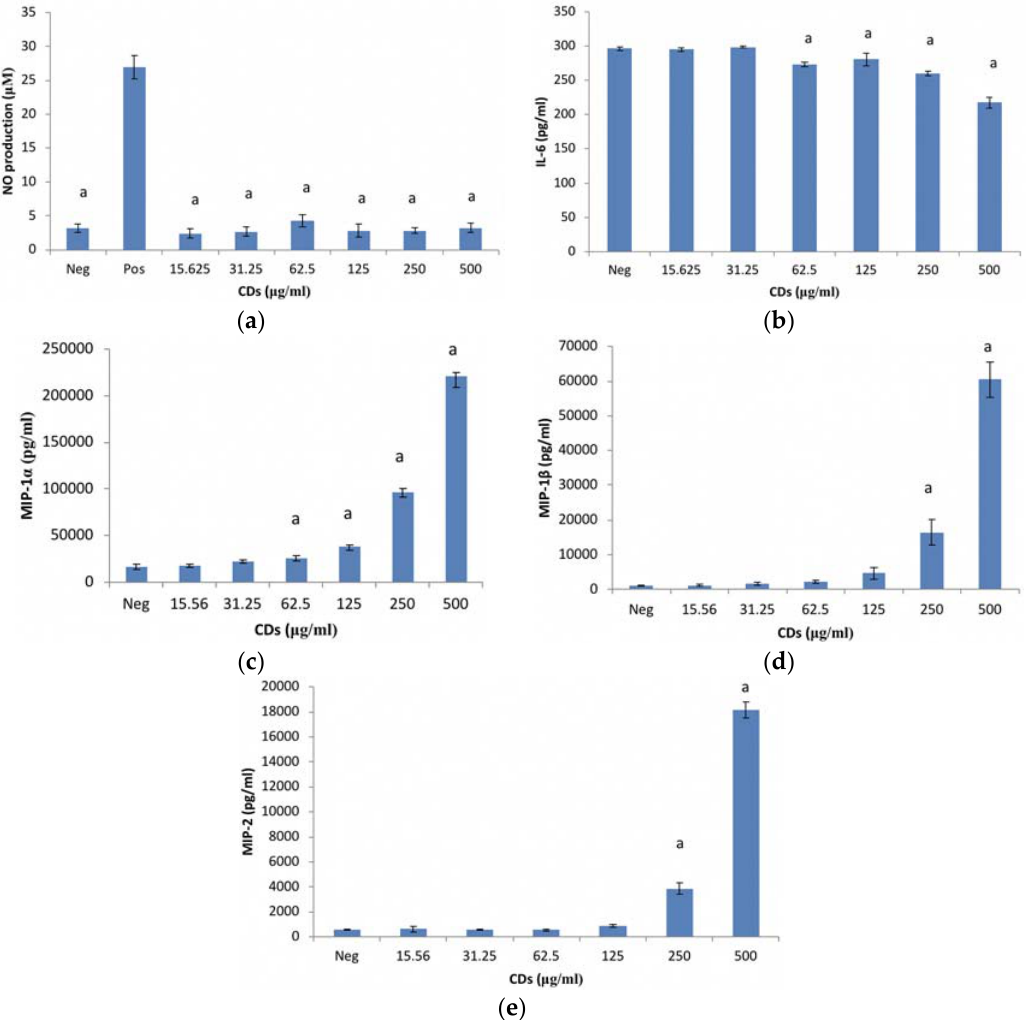
Figure 2. Murine macrophage, RAW 264.7 cells after treatment with CDs. Parameters assessed: ( a ) nitric oxide (NO) levels; ( b ) interleukin (IL) ‐ 6 production; ( c ) macrophage inflammatory protein (MIP) ‐ 1 α ; ( d ) MIP ‐ 1 β and ( e ) MIP ‐ 2 production of unstimulated RAW 264.7 cell cultures exposed to CDs. Data represents mean ± SD with n = 9. Bars marked with letters indicate significant differences ( p < 0.01). Significance demarcated by a: significantly different ( p < 0.001), compared to the LPS stimulated 0 μ g/mL CD control.